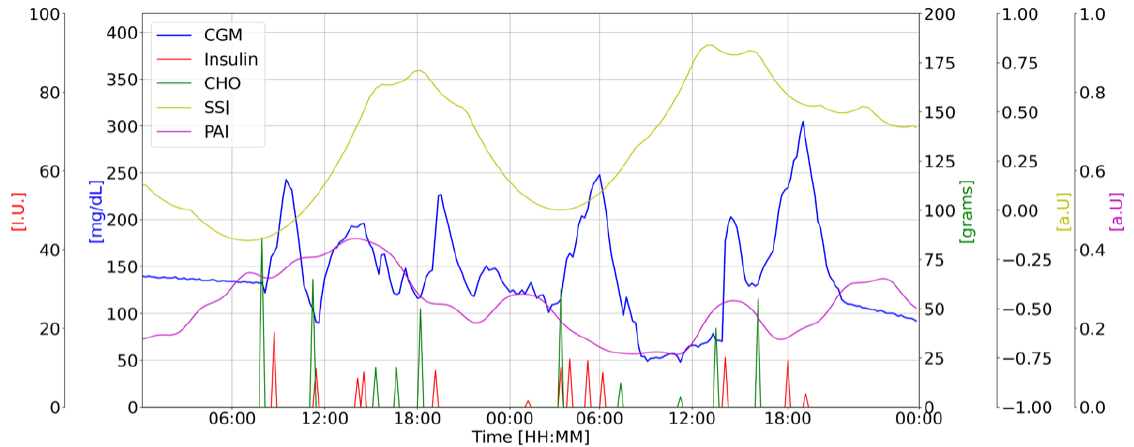
Figure 1. Representative subject’s data: CGM [mg/dL] (blue); CHO intake [g] (green); insulin doses [u] (red); PAI [a.u.] (purple) and SSI [a.u.] (yellow) vs. Time of the day [HH:MM].